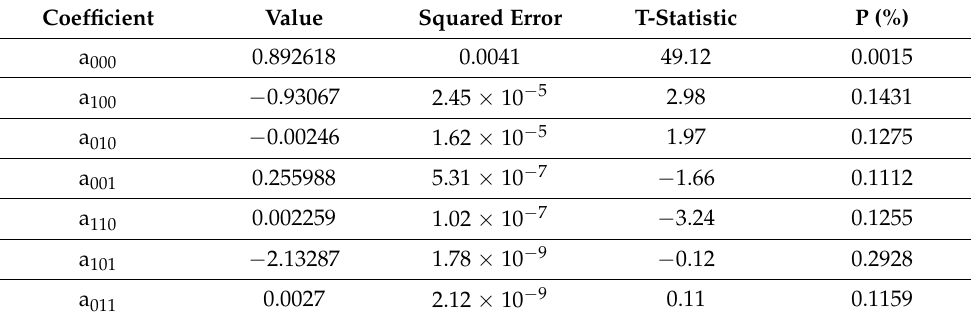
Table 3. Results of linear regression